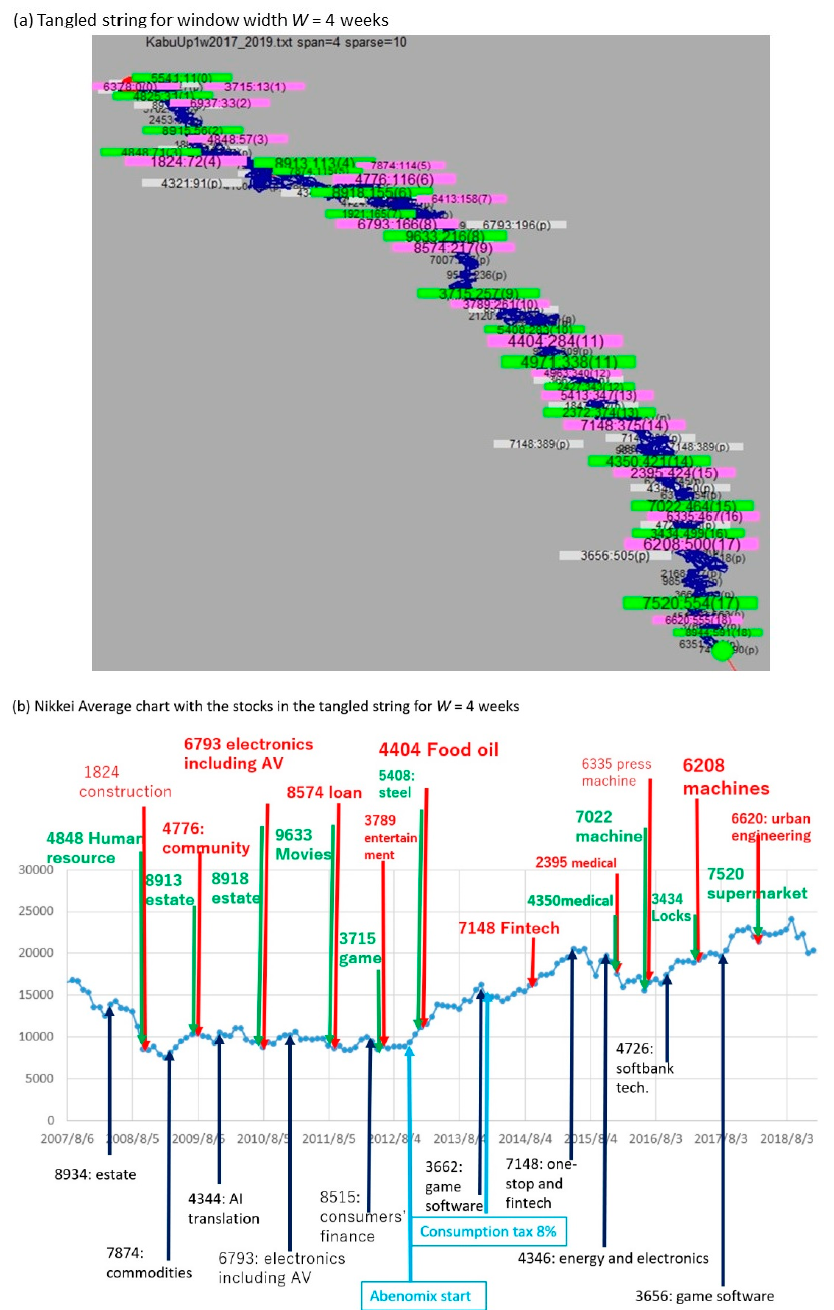
Figure 4. Results of TS for W = 4 (weeks) for the top-10 data. In ( a ), each red (pill entrance) or green (pill exit) node show X:Y:Z where X, Y, and Z represent the stock ID, its time (the week counted from the start of the sequence), and the number of pills counted from the beginning, respectively. The white node in ( a ) shows the most frequent token in each pill. ( b ) shows the timing of the nodes in ( a ) on the curve of the average price of all stocks (Nikkei Average).